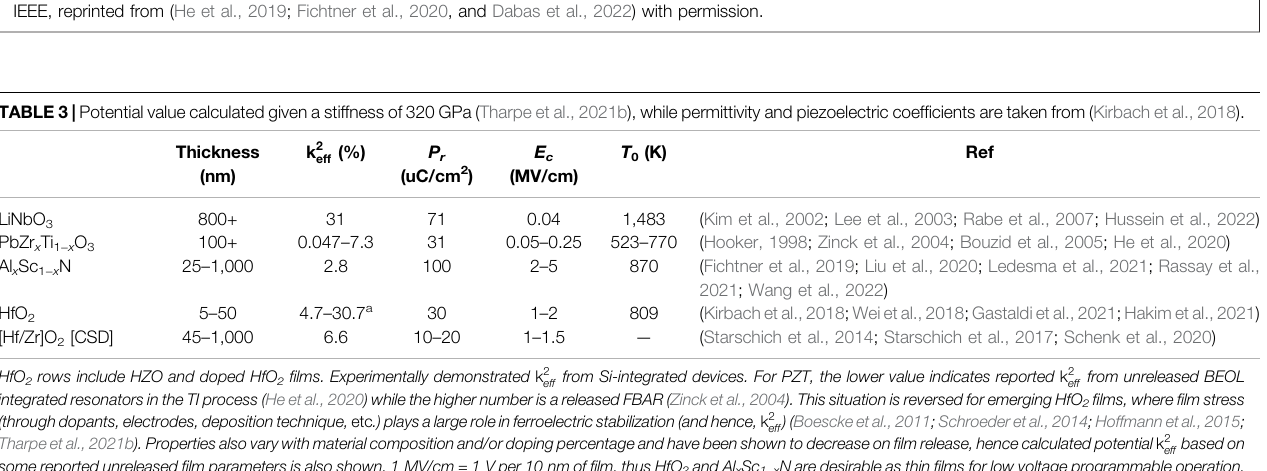
FIGURE 7 | Unit cells, clockwise from top left, of ferroelectric materials PZT, AlScN, and HfO 2 show bi-stable non-centrosymmetric behaviour indicative of ferroelectric materials (Rabe et al., 2007; Pinin, 2010; Boescke et al., 2011; Fichtner et al., 2019). (F) Coercive fi eld is not aset value but isa function of pulse width and voltage level, with probabilistic switching of domain. This has been exploited in (Dabas et al., 2022) to explore partial switching of AlScN at lower voltages for applications in temperature compensation. HfO